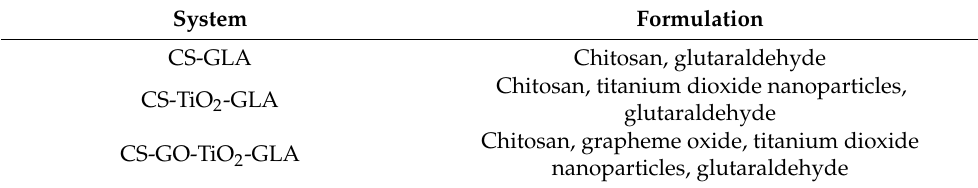
Table 1. Different formulations for the nanocomposite beads